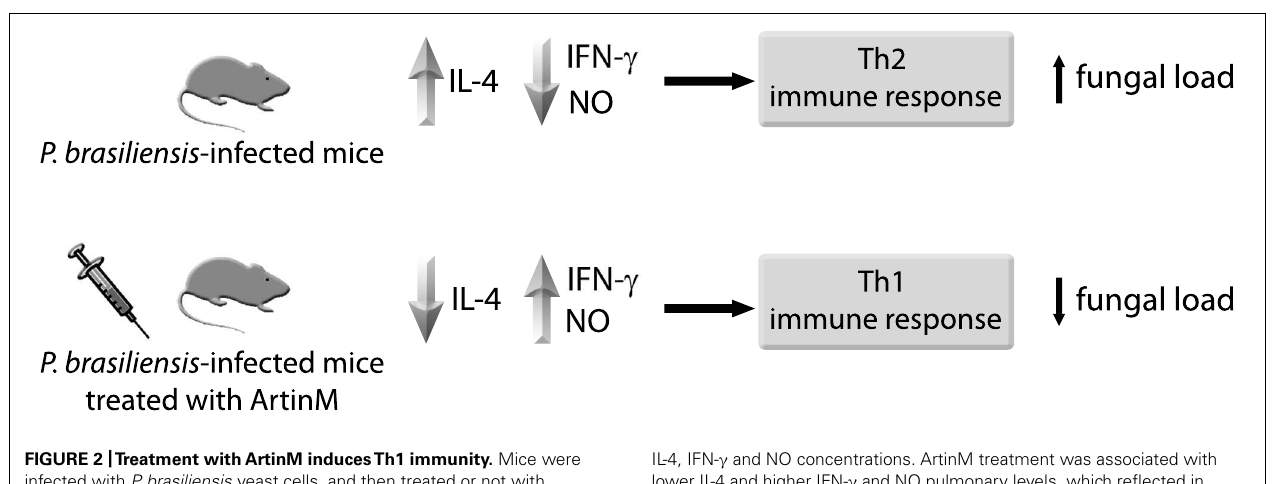
FIGURE 2 |Treatment withArtinM inducesTh1 immunity. Mice were infected with P. brasiliensis yeast cells, and then treated or not with ArtinM. On day 30 after infection, the mouse lung tissue was analyzed for